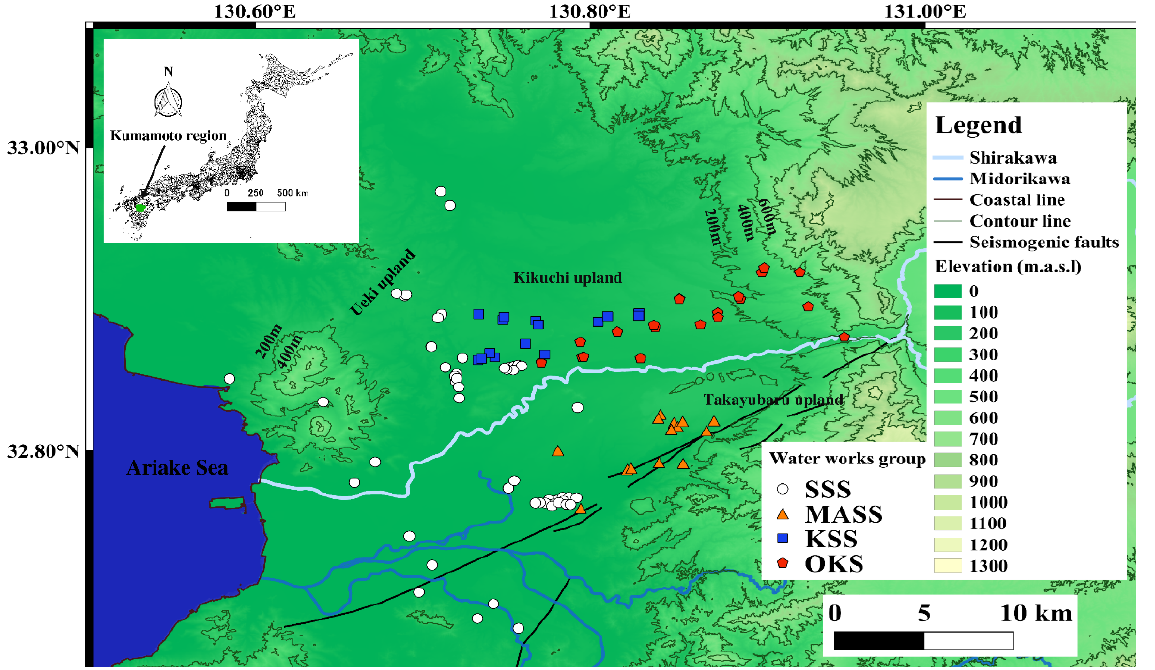
Figure 1. Kumamoto study area with sampling wells. Therein, four water work groups are represented: the Kumamoto City Waterworks and Sewerage Bureau (SSS), Koshi City (KSS), Mashiki Town Waterworks and Sewerage Bureau (MASS), and Water Works Bureau of Ozu Kikuyou (OKS), respectively.